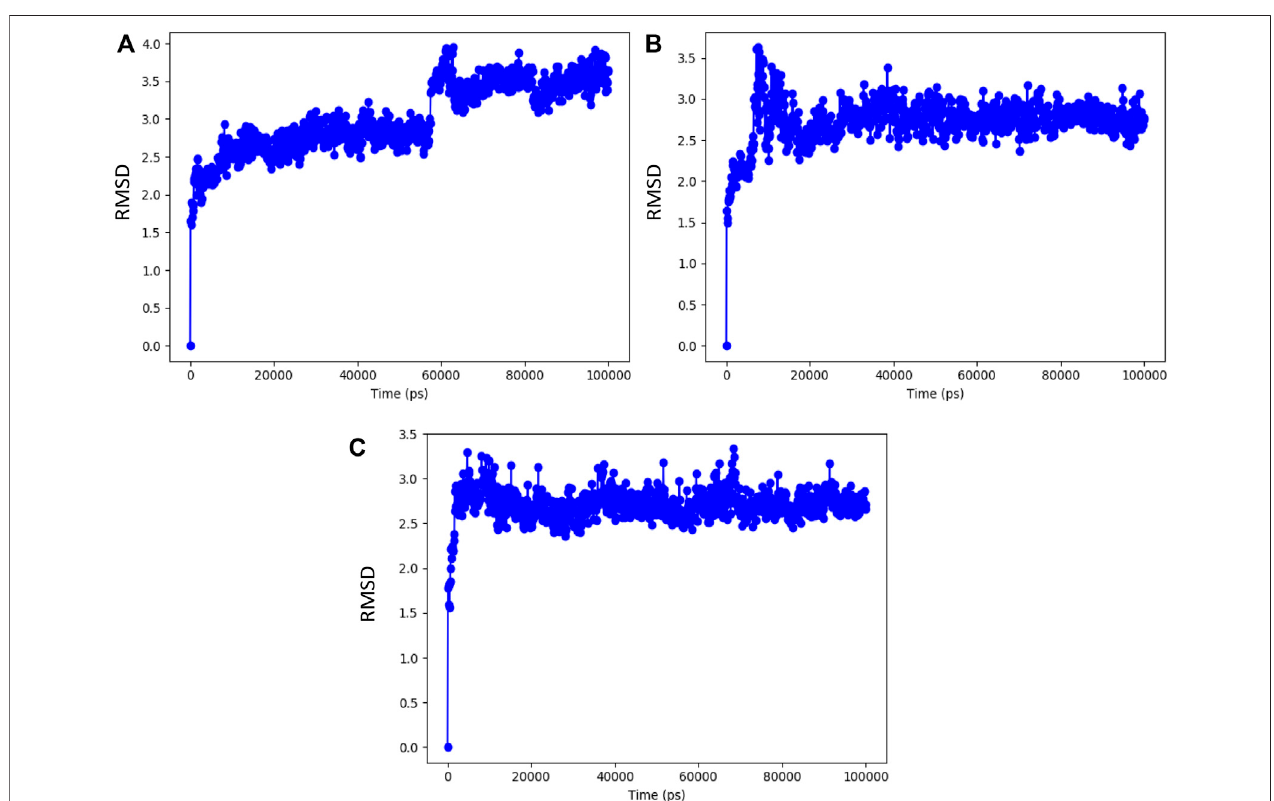
FIGURE 5 | RMSD value of the complex molecule of the main protease with (A) syzyginin B, (B) eugeniin, and (C) eugenol.